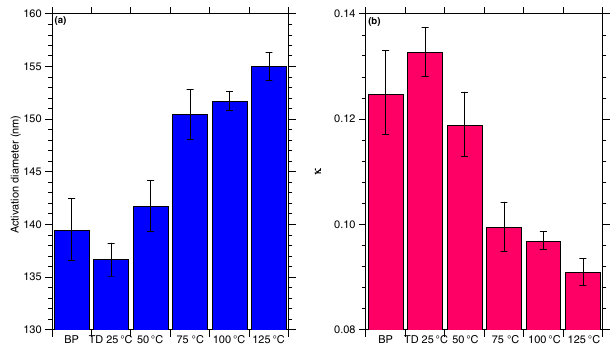
Figure 4. The average O:C ratio observed through the BP and sev- eral TD temperatures for Experiment 1. The error bars represent 1 standard deviation of the mean. The O:C ratios at a TD temperature of 50 ◦ C and greater were statistically smaller than the values at the BP and the TD at 25 ◦ C.